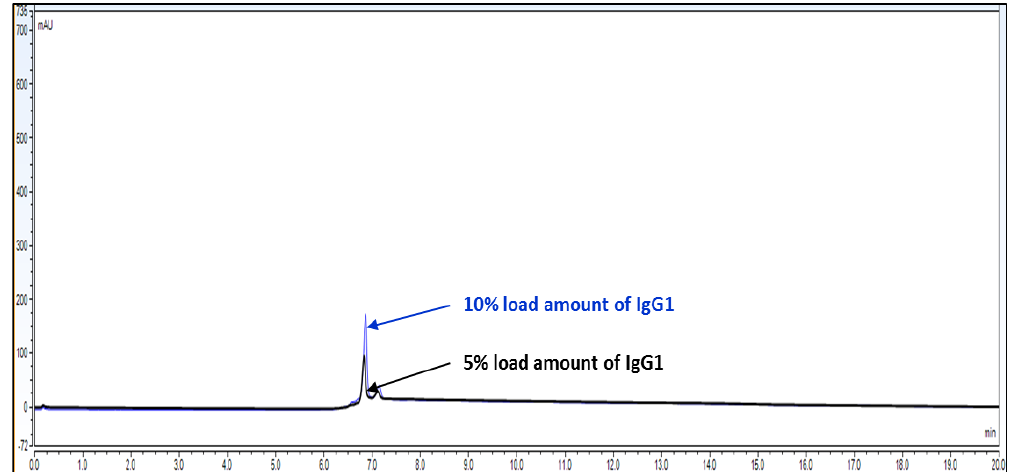
Figure 4. Overlay representative chromatogram for IgG1 sample loading of 10% and 5%, i.e., 0.30 mg/mL and 0.15 mg/mL from 100% standard injection amount, i.e., 3.0 mg/mL for LOQ calculation.